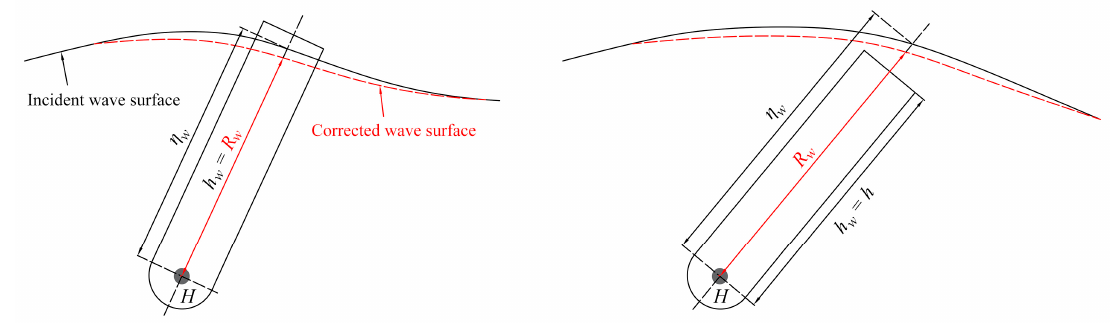
Figure 2. A schematic diagram of a corrected wave surface.